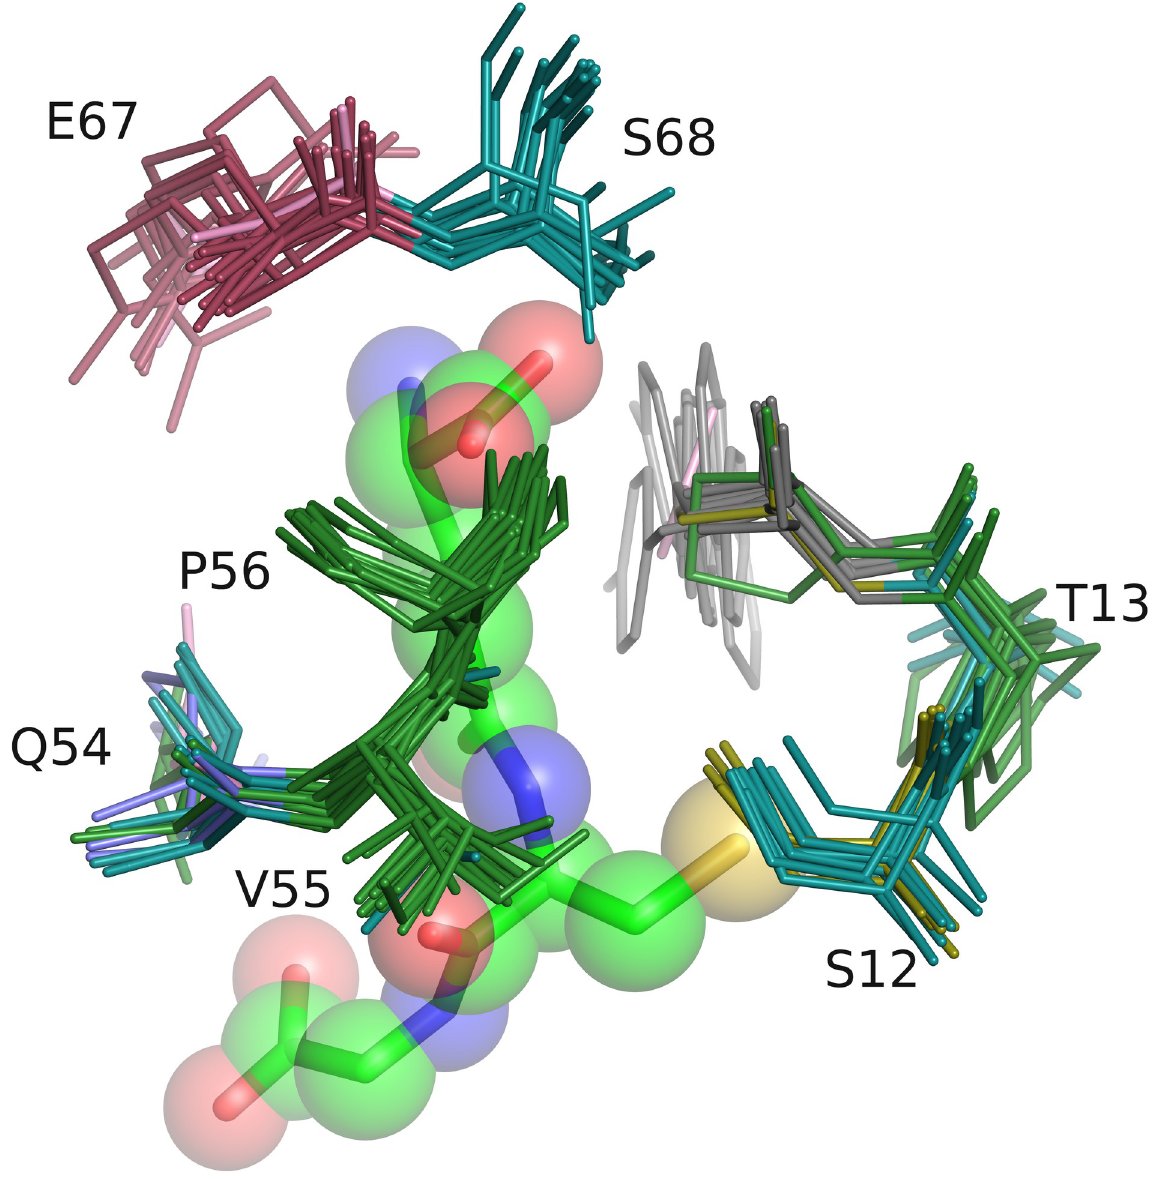
SiteMotif identifies two motifs [CS]-P-[FNWY] and [KQRTN]-[IV]-P-X(9,25)-[QED]-S that are known to be predominant in proteins binding GSH